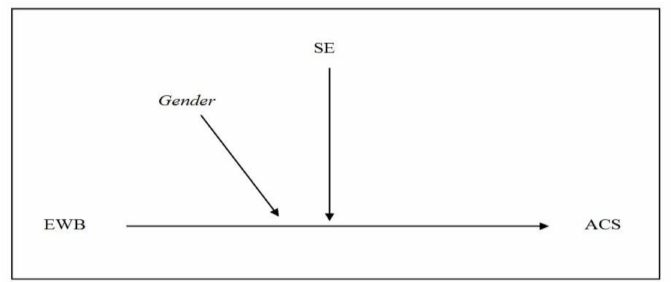
Figure 2. Moderation model. EWB = Eudaimonic Well-Being; SE = Self-Efficacy; ACS = Adaptive Coping Strategies.